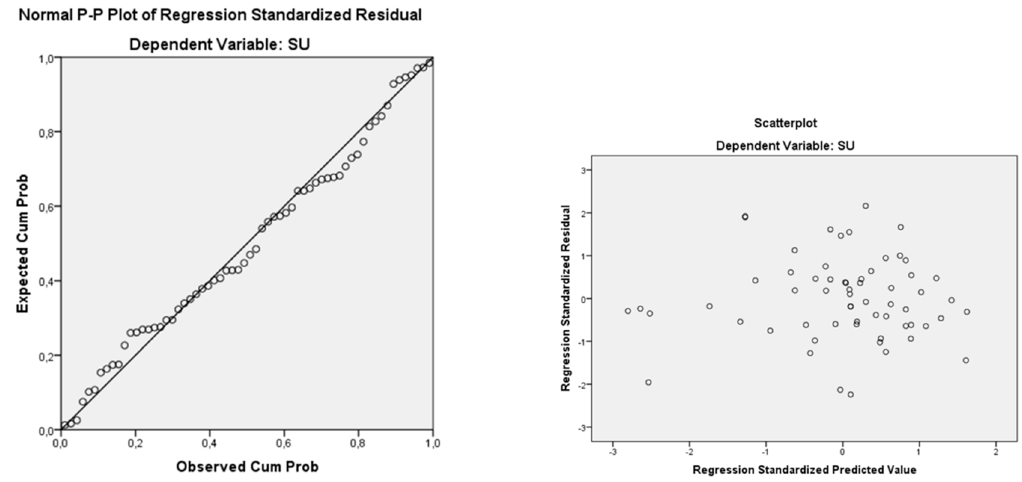
Figure 1. Standard P-P plot of the regression standardized residual and a residual scatter plot.